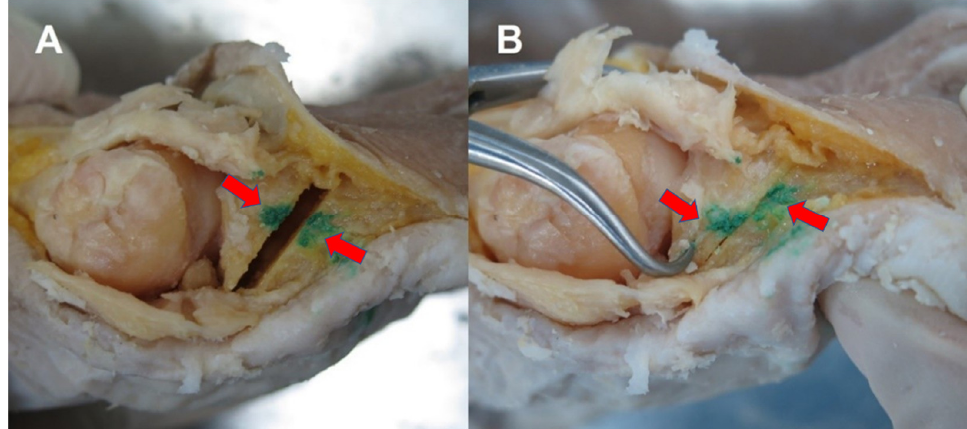
Figure 2. Modified proximal phalanx osteotomy performed by ( A ) an oblique medial closed wedge osteotomy for correcting hallux valgus; ( B ) rotation of the distal segment for reducing the sesamoid bones.